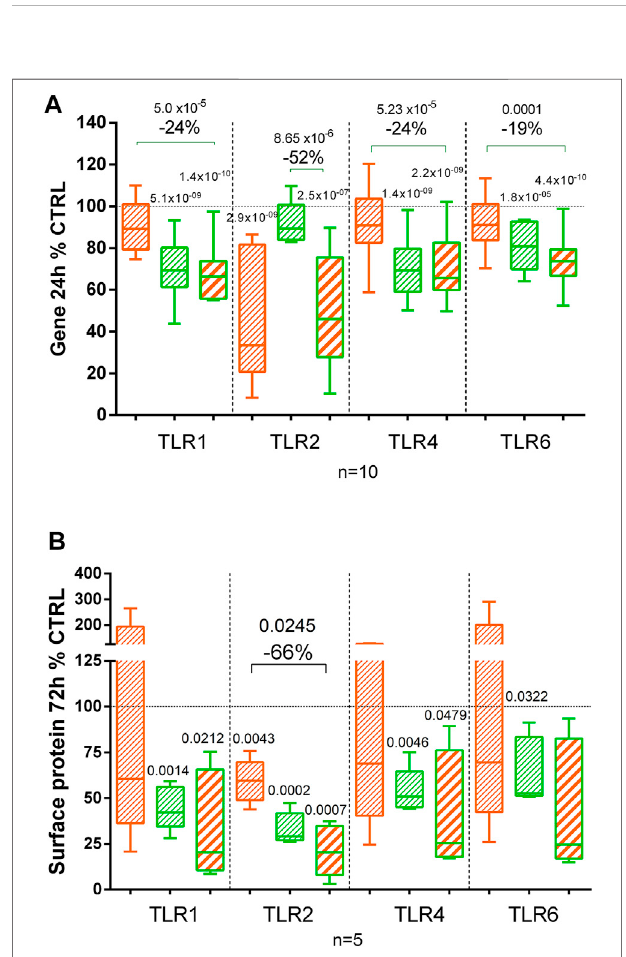
FIGURE 6 | Effect of C. longa 2 μ g/ml, B. serrata 50 μ g/ml, and combinationof C.longa and B.serrata onTLRsgeneexpression( A ,RNA-seq at 24 h, n = 10) and surface protein ( B , 72 h, n = 5). Signi fi cant statistical differences are shown compared to the control or between treatments (shown with a